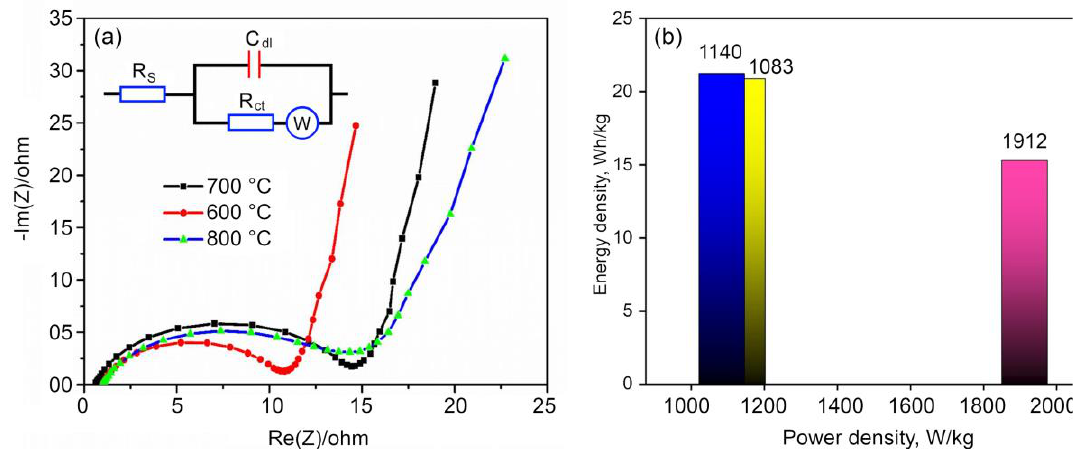
Figure 7. ( a ) Electrochemical impedance spectrum (EIS) measurements of the 3D nitrogen self-doped graphene-based carbon aerogel activated at 700 °C, 800 °C, and 900 °C. ( b ) The Ragone plot of the 3D graphene nitrogen-doped carbon aerogel activated at 700 °C (yellow bar), 800 ° C (blue bar) and 900 ° C (pink bar).